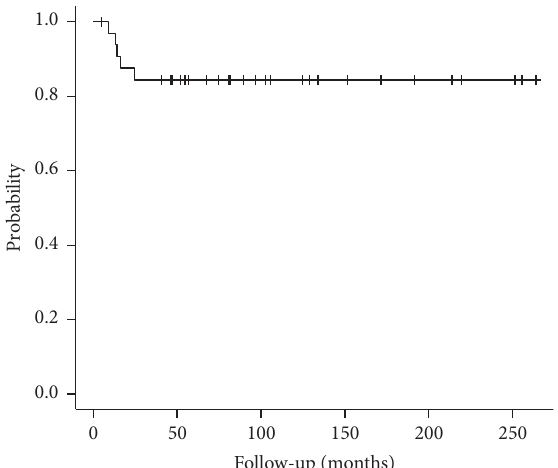
Figure 3: A survival curve of osteoarticular extracorporeal irradiate autograft in this